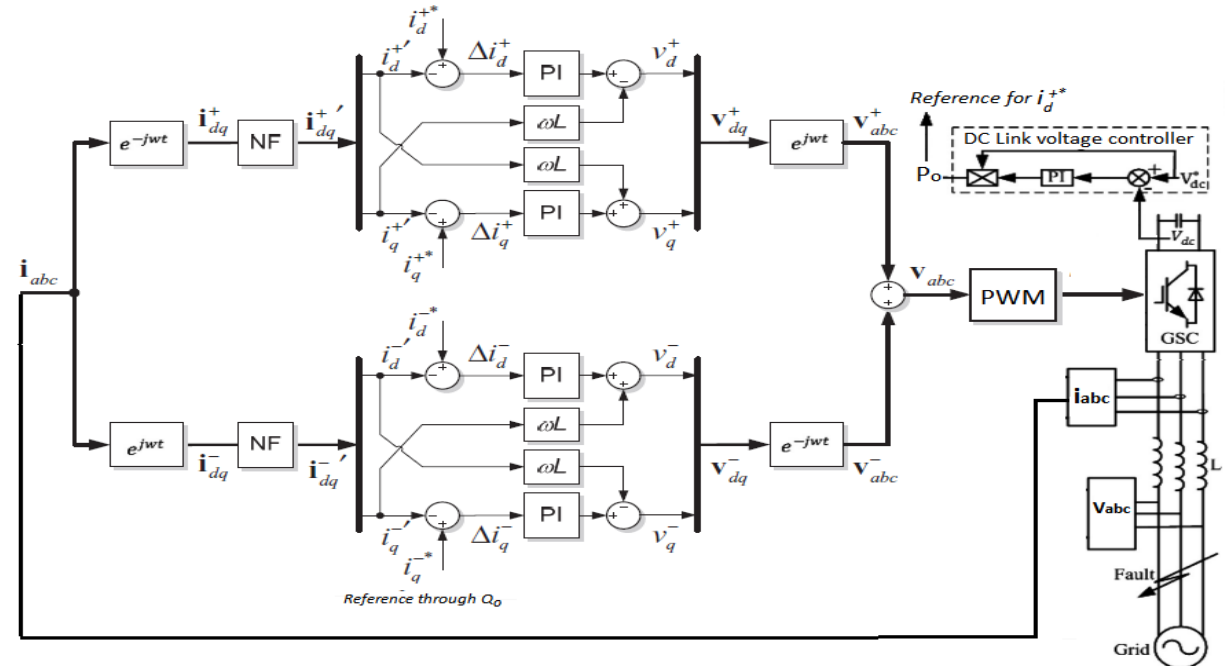
Figure 5. Schematic of Grid Side Converter using Dual Current Controller.